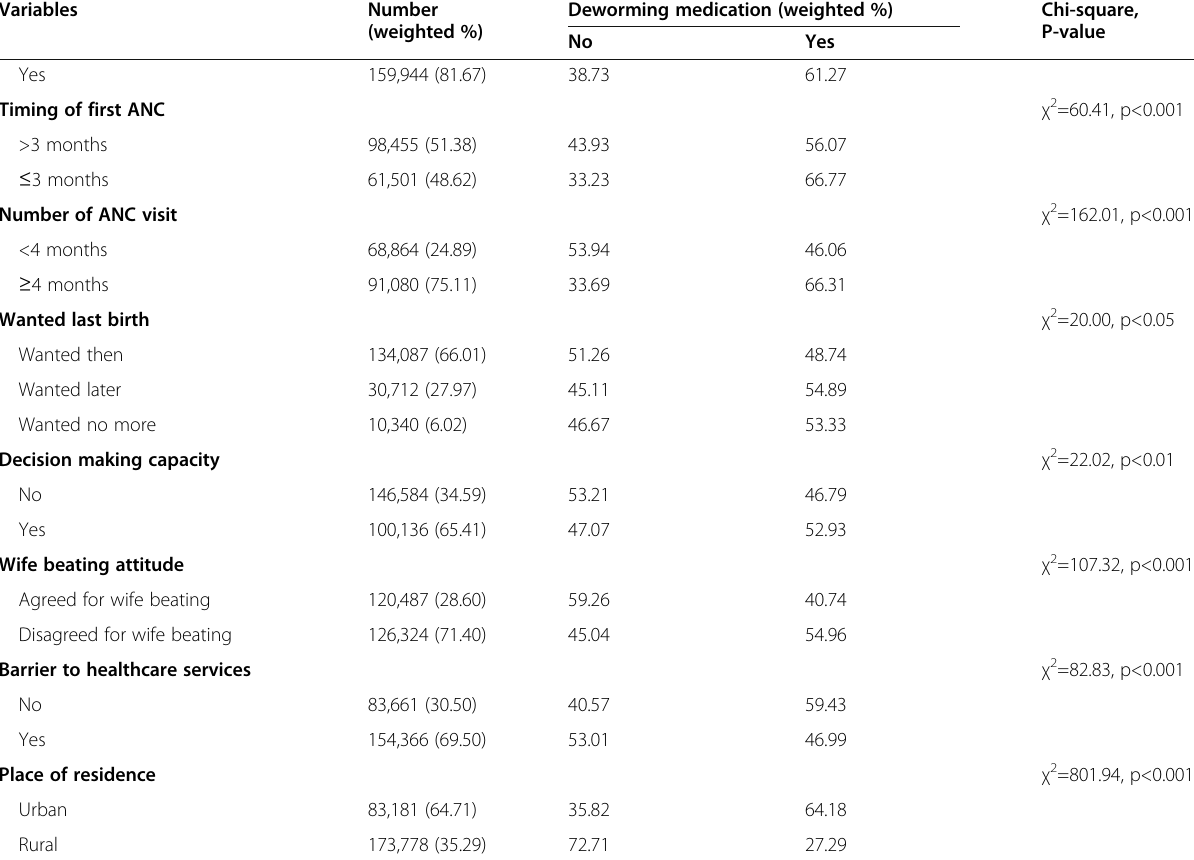
Table 2 Frequency distribution of study participants and deworming distribution across explanatory variables: evidence from 26 sub-Saharan African countries DHSs